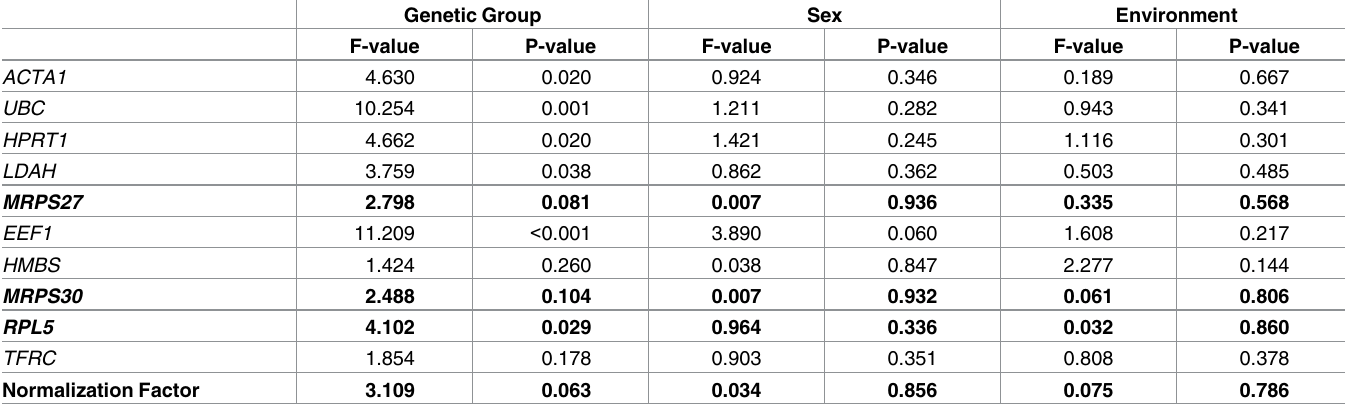
Table 11. ANOVA analysis of Ct values of genetic group, sex and environment effects among previous chosen genes. Genetic Group Sex